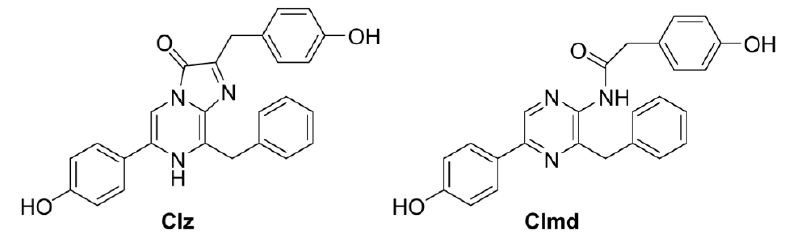
Figure 1. Chemical structures of native Clz and Clmd.